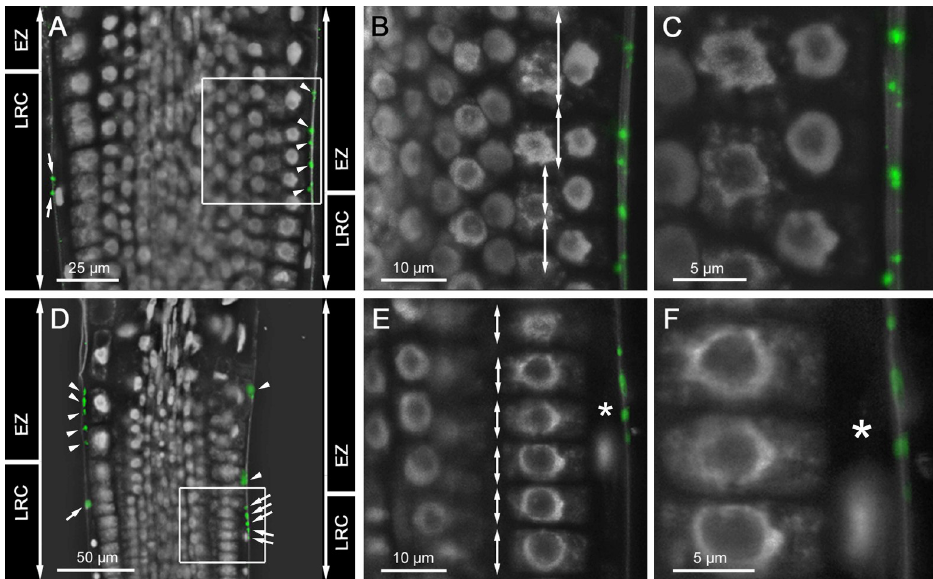
Fig 9. CEP2 is immunolocalized to root cap corpses sticking to epidermis cells in the rapid elongation zone. (A and D) Two root tips of 10 days old WT seedlings incubated with anti-CEP2 peptide antibody and cyanine CY2-coupled secondary antibody are analyzed by CLSM (Leica SP8). Nuclei are characterized by their strong white auto fluorescence, whereas other parts of the cell are barely fluorescing and look black. (A-C) is focusing on epidermis cells of the elongation zone (EZ), whereas (D-F) is focusing on cells at the upper end of the LR cap (LRC) with two different magnifications of the white boxed area in (B-C) and (E-F), respectively. LR cap cells are long and small with one single nucleus (see asterix in E and F), whereas epidermis cells are short at the level of the LR cap and are elongating at the level of the rapid elongation zone (compare double arrows in B and E). CEP2 signals (green) are exclusively found in LR cap cells (see arrows in A and D) and in root cap corpses sticking to the cell wall of epidermis cells at the beginning elongation zone (see arrow heads in A and D).